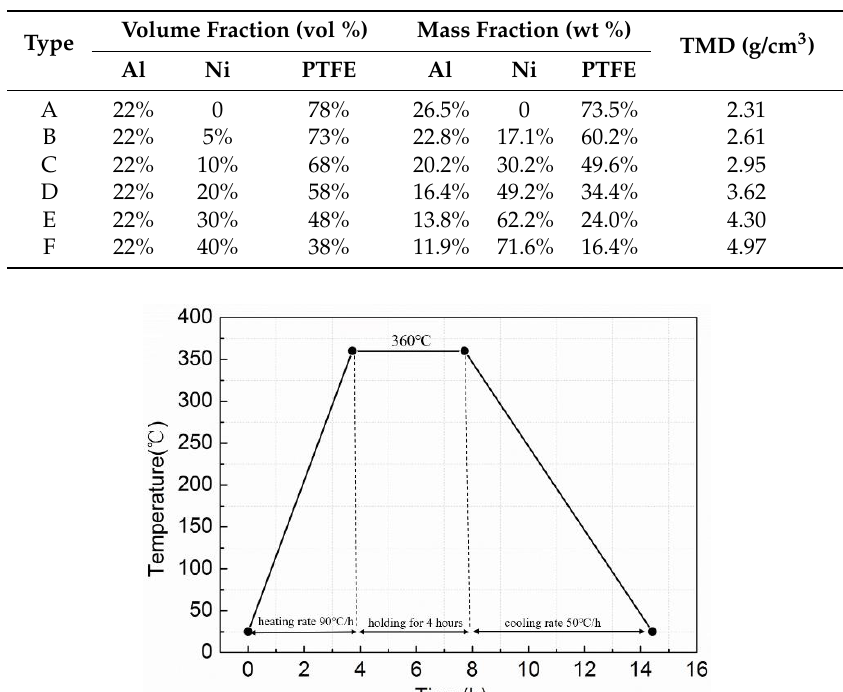
Table 1. The equivalence ratios and TMD (theoretical maximum density) of the six types of Al-Ni-PTFE specimens.